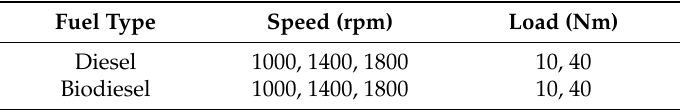
Table 6. Properties of biodiesel [23].